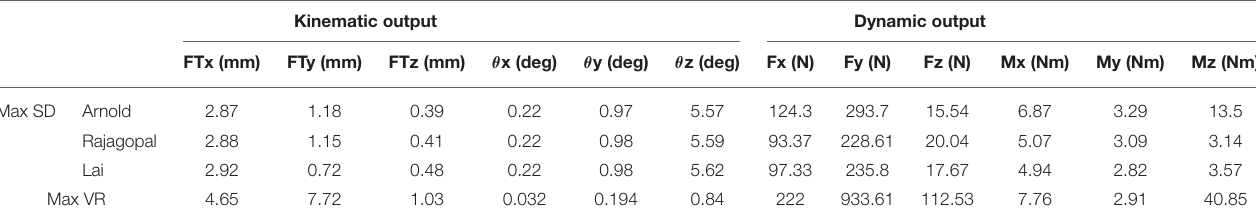
TABLE 2 | Within and between model variability in terms of maximum SD values and variation range for all the quantities that define the kinematic and dynamic musculoskeletal simulation output. Kinematic output Dynamic